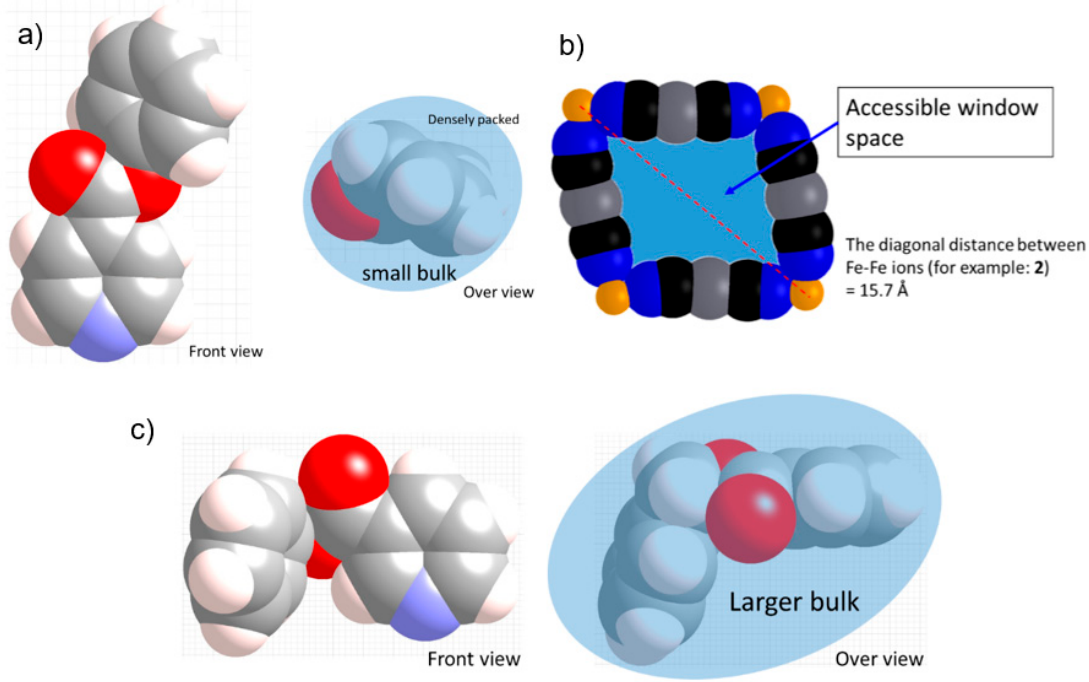
crystal structure